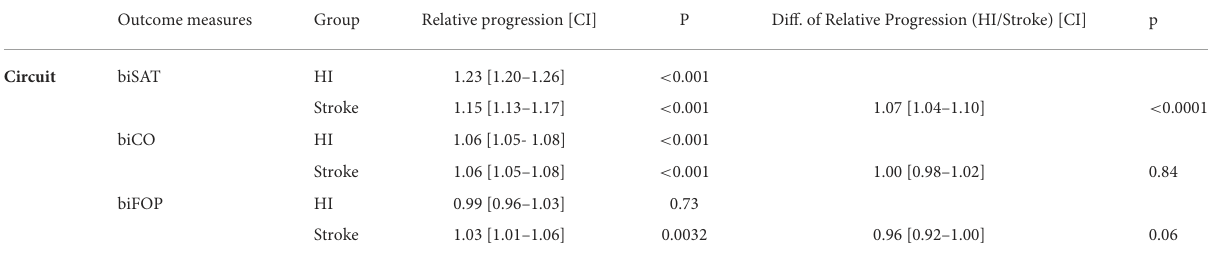
TABLE 5 Healthy individuals and patients with stroke (sham): Progression during training. Outcome measures